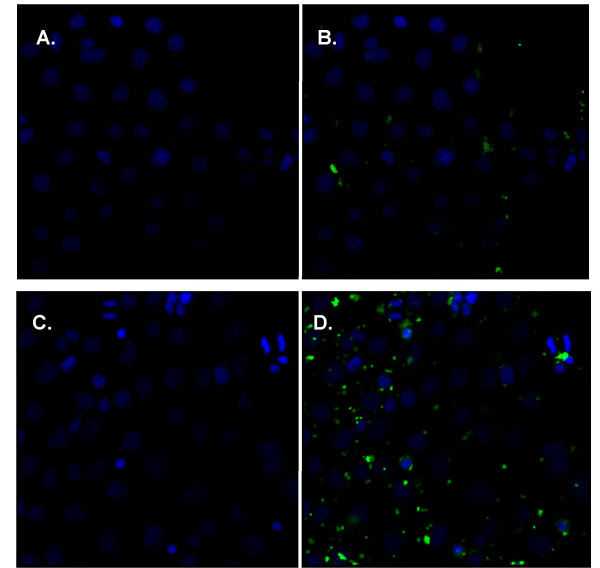
Distribution of FITC-labelled siRNA in M1 cells in vitro. M1 cells were transfected with Lipofectamine 2000-complexed FITC-labelled siRNA. At indicated time-points after transfection cells were harvested and processed for confocal microscopy. Nuclei were stained with DAPI and are shown in blue (left panel), FITC signal is shown in green (right panel). A and B show biodistribution 30 min after transfection, C and D show biodistribution 24 hrs after transfection.